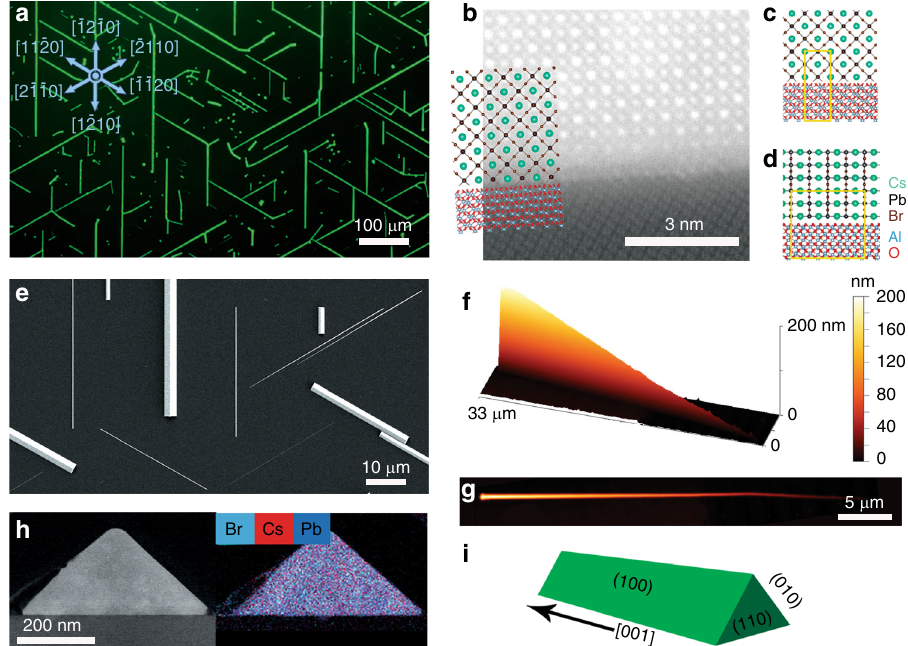
Fig. 1 Surface-guided epitaxial CsPbBr 3 nanowires on C-plane sapphire. ( a ) An optical photoluminescence image of surface-guided nanowires and microwires emitting green luminescence during wide- fi eld excitation with a blue (405 nm laser). The growth directions of the nanowires on the sapphire substrate are marked with blue indices and vectors. ( b ) Cross-sectional atomic-resolution STEM HAADF image taken in the ½ 11 (cid:1) 20 (cid:2) viewing direction of the sapphire substrate. The atomistic model overlay shows the atomic positions that are associated with the bright dots in the HAADF image. Detailed view of the atomic model ( c ) across and ( d ) along the growth axis of the nanowires. The yellow rectangles mark the repeat period (see also Supplementary Fig. 1 for a top-view of the epitaxial relations). e SEM image of nanowires with highly varying heights. ( f – g ) A typical tapered nanowire with a height gradient is displayed in 3D ( f ) and 2D ( g ) AFM images. ( h ) TEM image and EDS elemental map of a typical triangular cross-section. ( i ) Illustration of the shape, facets and growth direction of CsPbBr 3 surface-guided (cid:1) the six isoperiodic A ± < 11 20 > directions of the sapphire sub- strate, re fl ecting its symmetry (Fig. 1a and Supplementary Fig. 1).